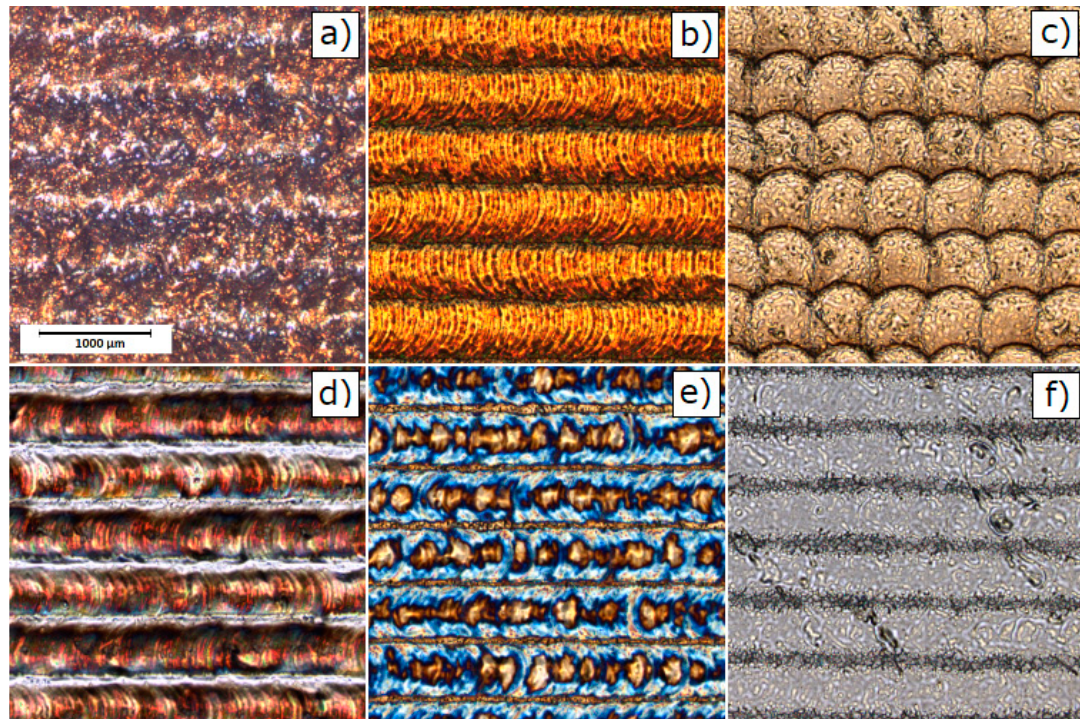
Figure 2. The AISI 304 COM images of surfaces treated with different laser marking parameters (i.e., scanning speed, pulse repetition rate) recorded for: ( a ) 304_20_10; ( b ) 304_20_100; ( c ) 304_20_1000; ( d ) 304_80_10; ( e ) 304_80_100; and ( f ) 304_80_1000 samples (naming of samples: see Table 2).